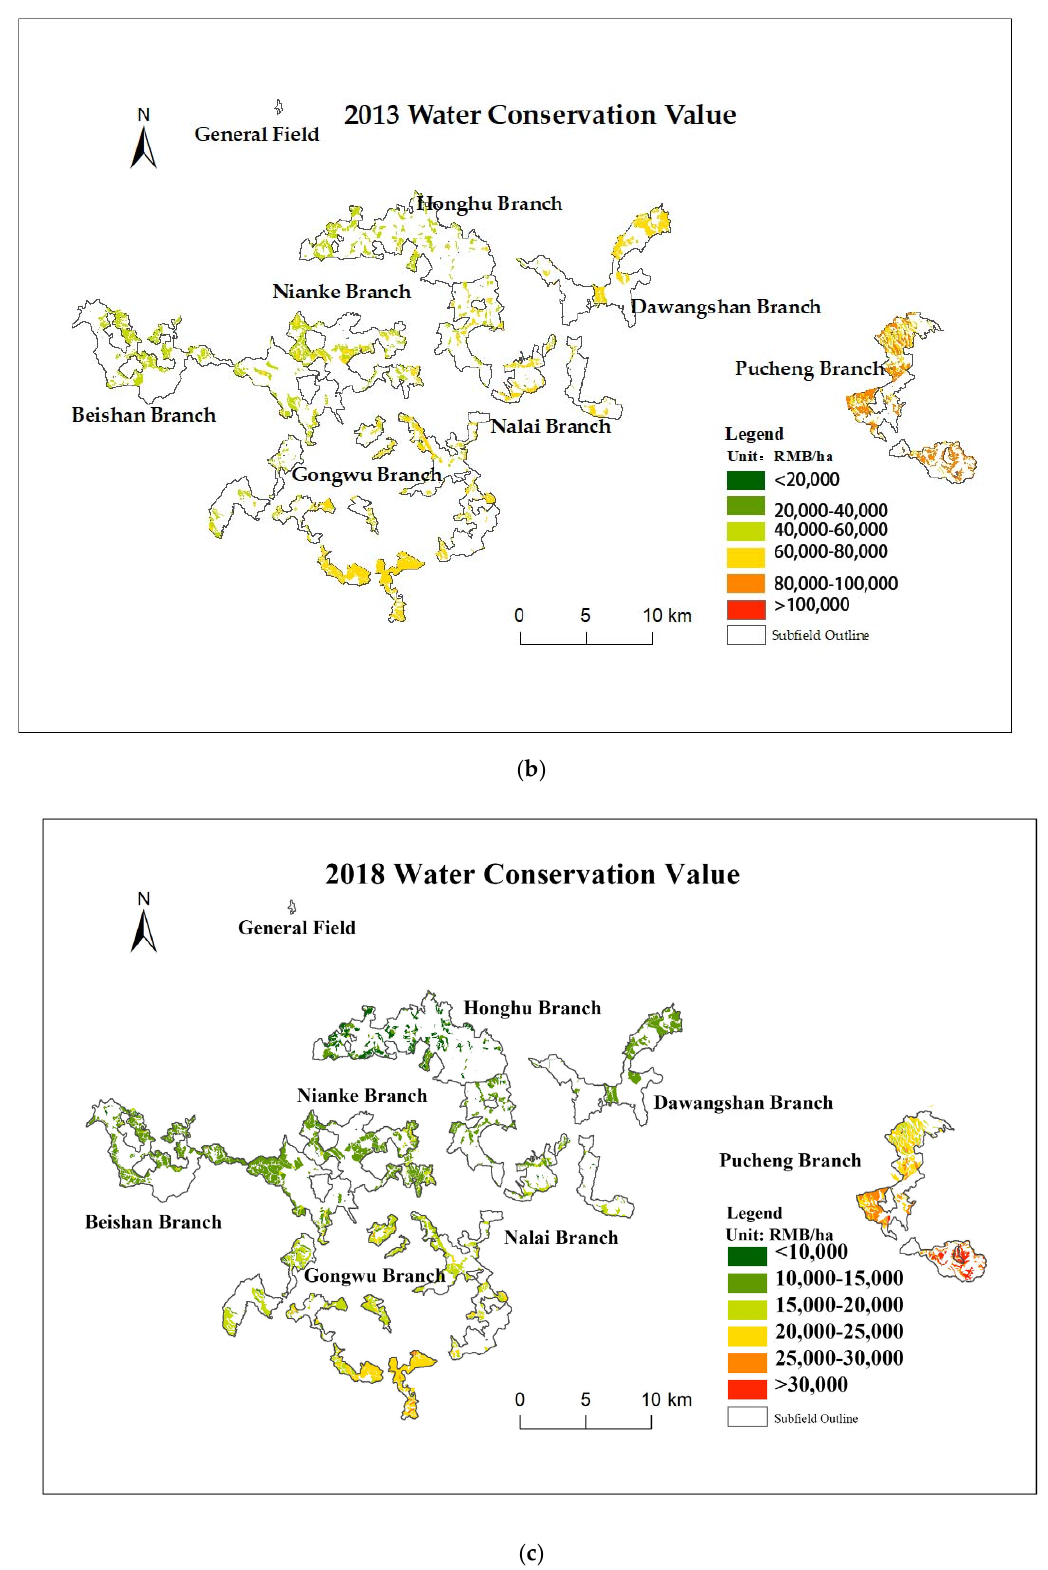
Figure 5. Spatial distribution map of the water conservation values of PM plantations in the northern tropical case study area in 2009–2018. ( a ) 2008 Water conservation value; ( b ) 2013 Water conservation value; ( c ) 2018 Water conservation